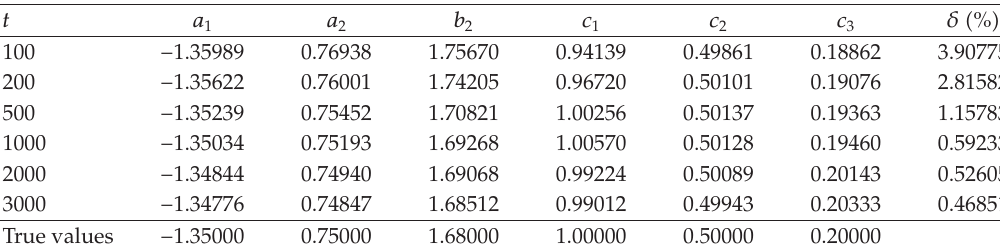
Table 2: The parameter estimates (cid:2) θ s (cid:3) (cid:2) σ 2 (cid:7) 0.50 2 , δ ns (cid:7) 10.96% (cid:3)